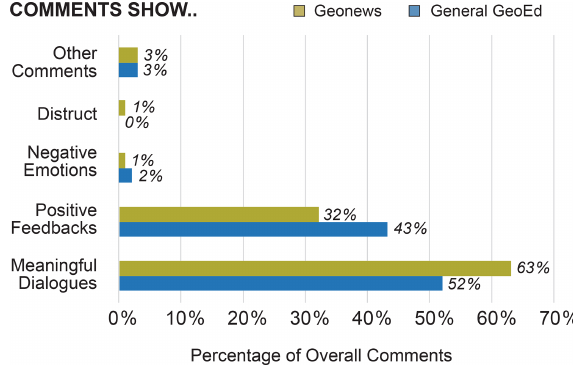
Figure 4. Comparison of comments about Geonews videos ( N = 73) and General GeoEd videos ( N = 149). Data are as of 10 March 2021. All the values are rounded to the nearest integer. See the text for a detailed